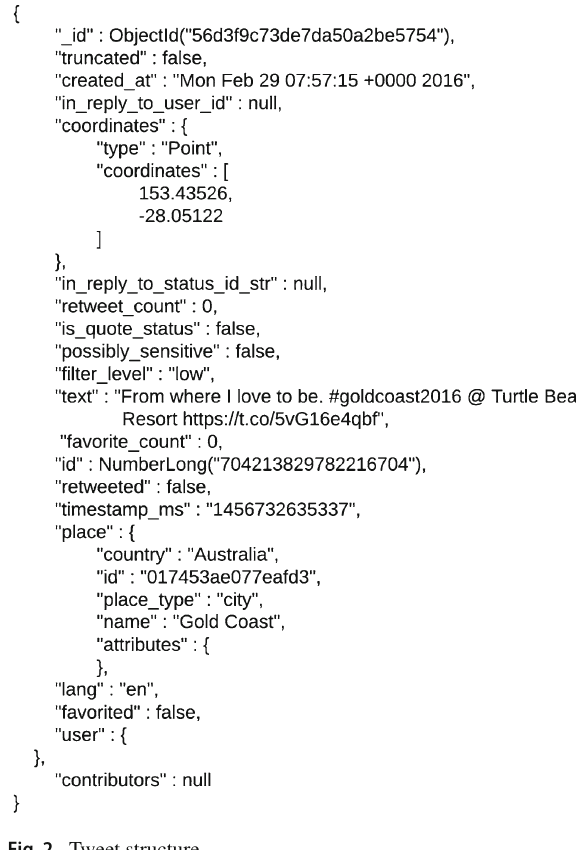
Fig. 2 Tweet structure